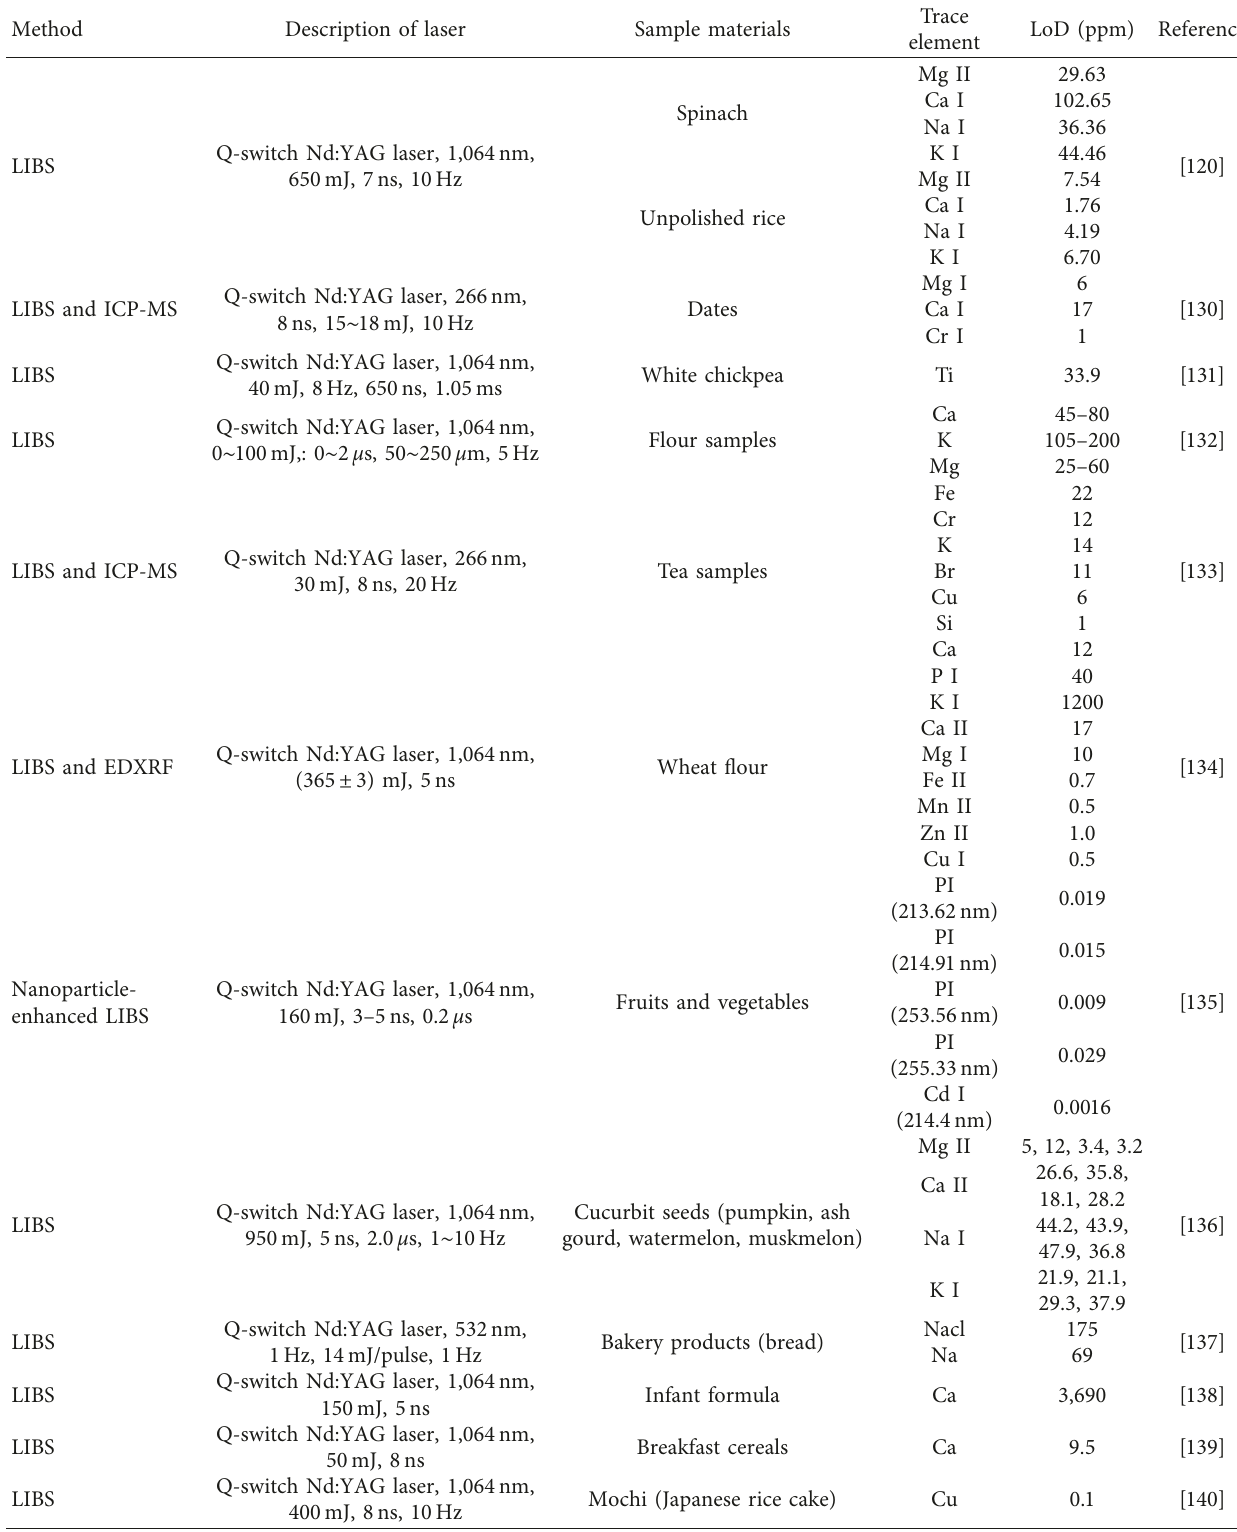
Table 3: LIBS conditions and corresponding LoDs of trace elements in